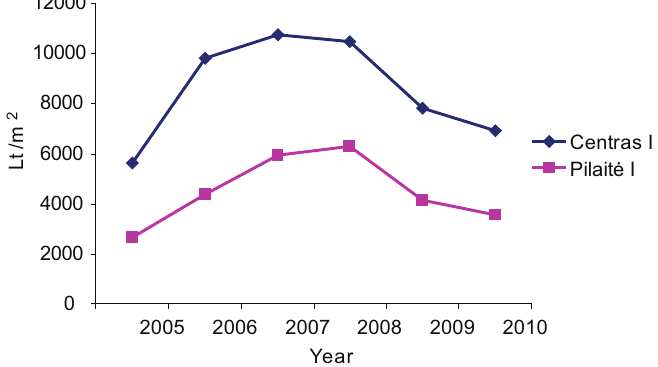
figure 1. Changes in prices of real estate in the Old Town and Pilaitė (JSC “ober-House” monitoring